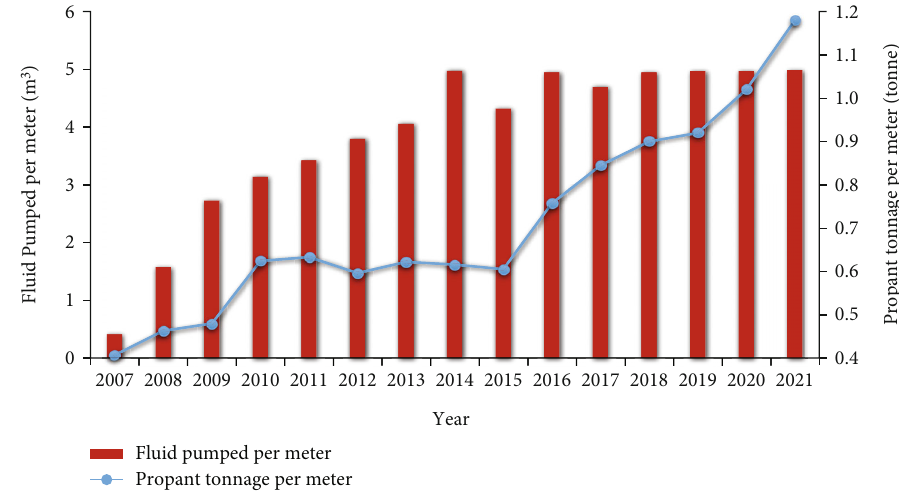
Figure 4: History of the completion parameters in Montney Formation in the Groundbirch